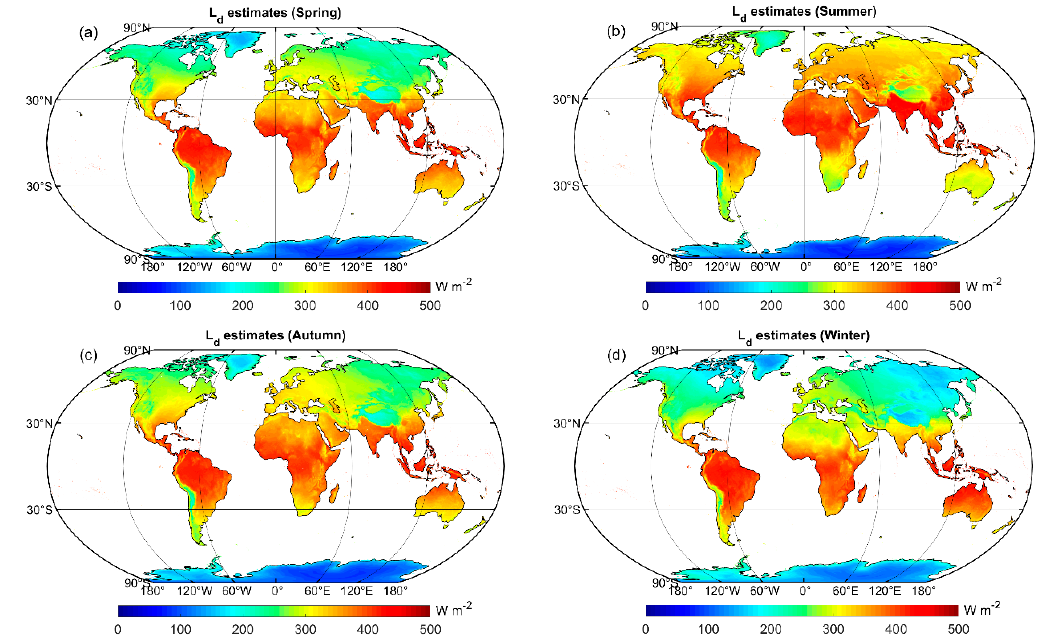
Figure 8. The spatial distribution of the multiyear seasonal mean value of the generated L d dataset in Northern hemisphere ( a ) spring (March, April, and May), ( b ) summer (June, July, and August), ( c ) autumn (September, October, and November), and ( d ) winter (December, January, and February) over the global land surface from 2003 to 2018.